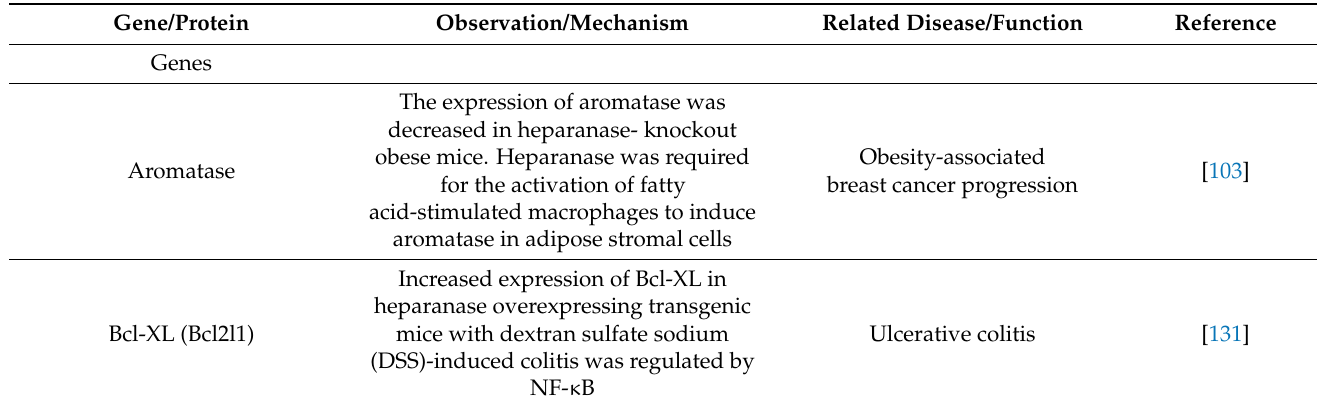
Table 3. Genes and proteins that are regulated by